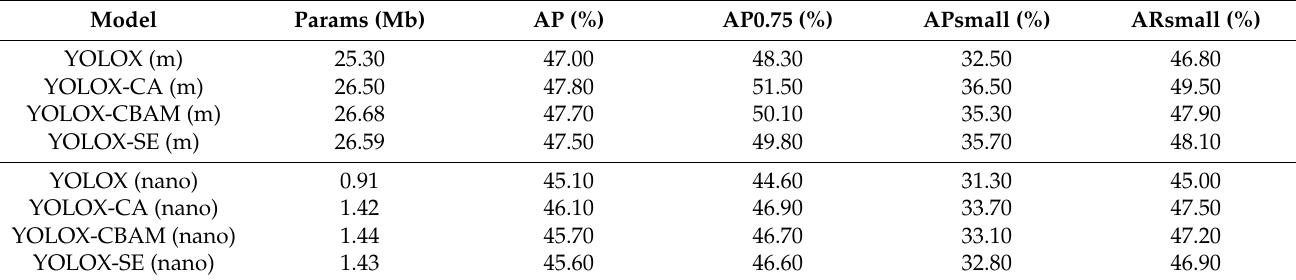
Table 4. The effect of different attentional mechanisms on the YOLOX-Pro